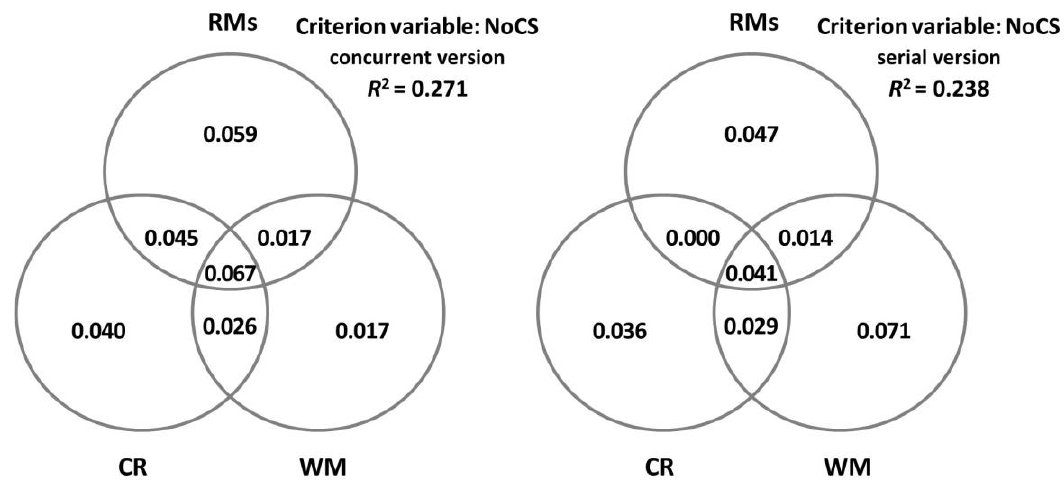
Figure 3. Decomposition of the variance in canonical sentences (CSs) explained jointly and uniquely by cognitive reserve (CR), measured by the cognitive reserve questionnaire (CRQ); working memory (WM), measured by the digit ordering task (DO); and the rest of the measures (RMs: age, MMSE, GDS-15, and MFE).